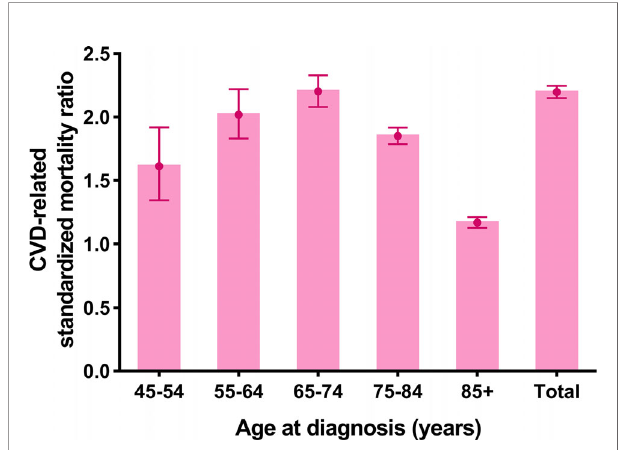
FIGURE 2 | Cardiovascular death (CVD)-related standardized mortality ratios (SMRs) for breast cancer patients without chemotherapy or